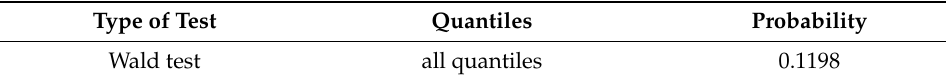
Table 7. Test of equality of coefficients at all quantiles.